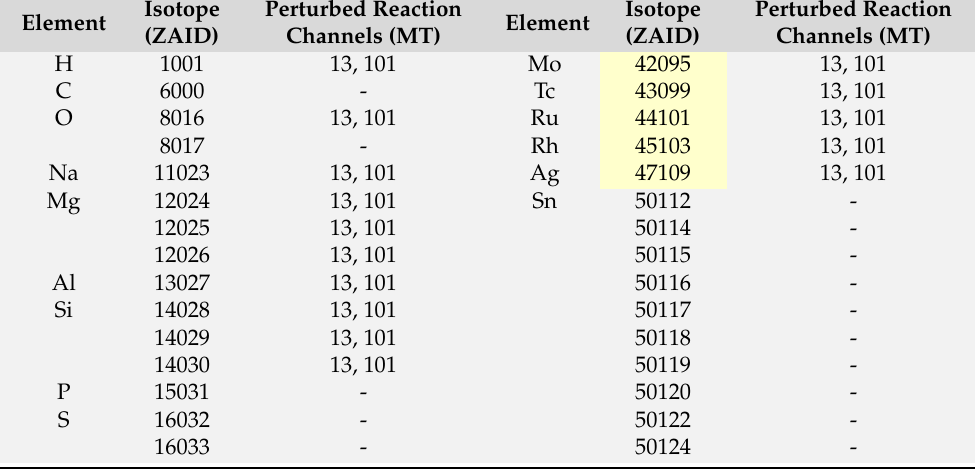
Table 4. List of 90 isotopes present in the MNCP6 input files, 56 isotopes thereof with perturbed nuclear data and reaction channels. AC + FP nuclides highlighted in red and yellow, respectively, as specified in